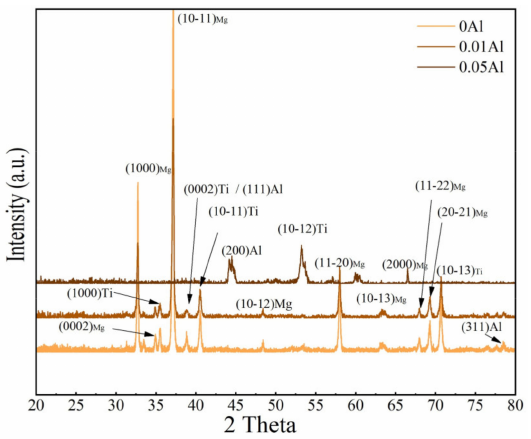
Figure 2. XRD pattern of rolled Mg-(Al-)Ti sheets with different thicknesses of Al layer, and corre- sponding standard powder diffraction file (PDF) card peaks of α -Ti, Al, and Mg are also marked at the